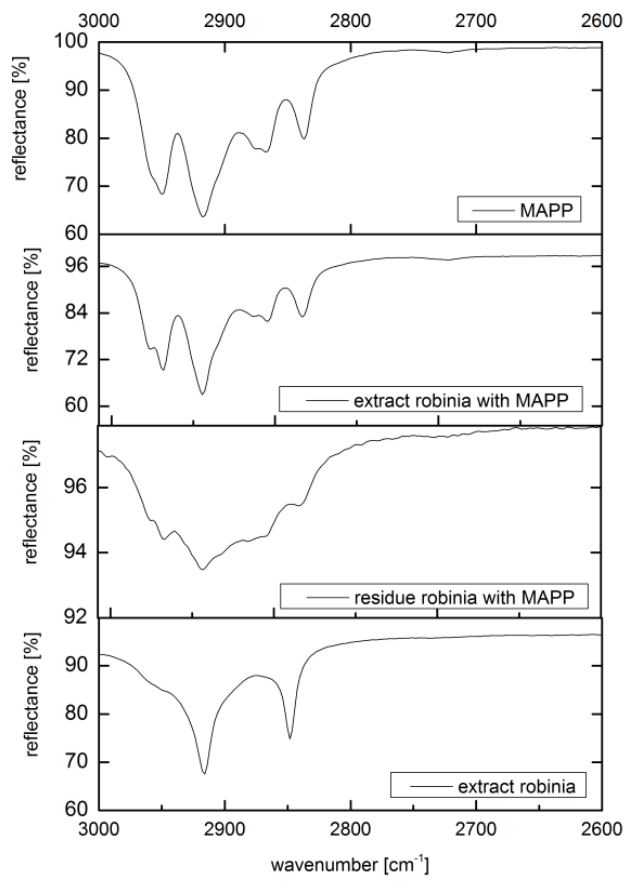
Figure 12. ATR-FTIR spectra of extracts of Robinia TMP with and without emulsified MAPP and of residue.